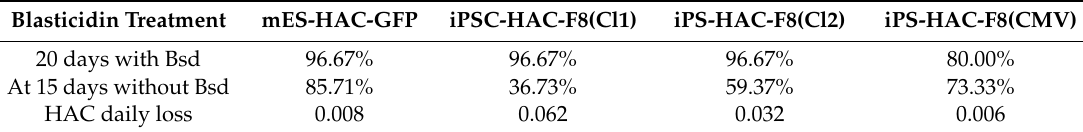
Table 2. The rates of HAC vector loss during cell division. HAC vectors daily losses determined based on quantification of metaphase spreads of the HAC-bearing